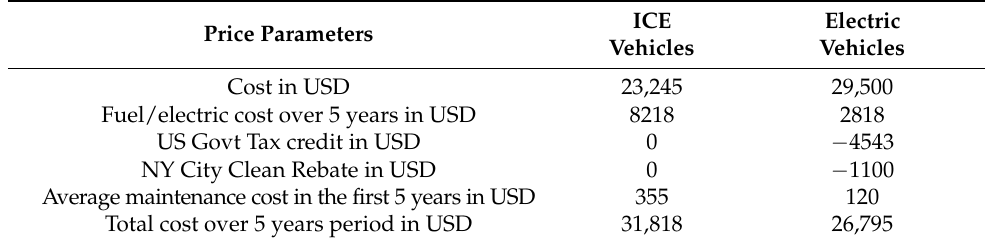
Table 6. Economic analysis of gasoline vehicles and electric